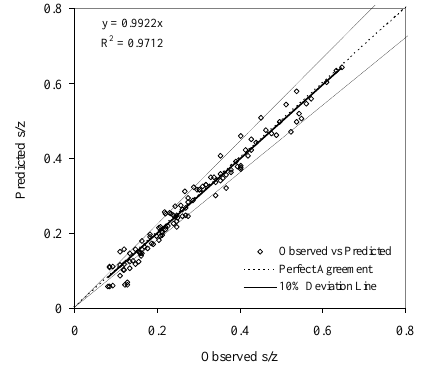
Figure 7. Comparison between observed and predicted GP to estimate s/z .